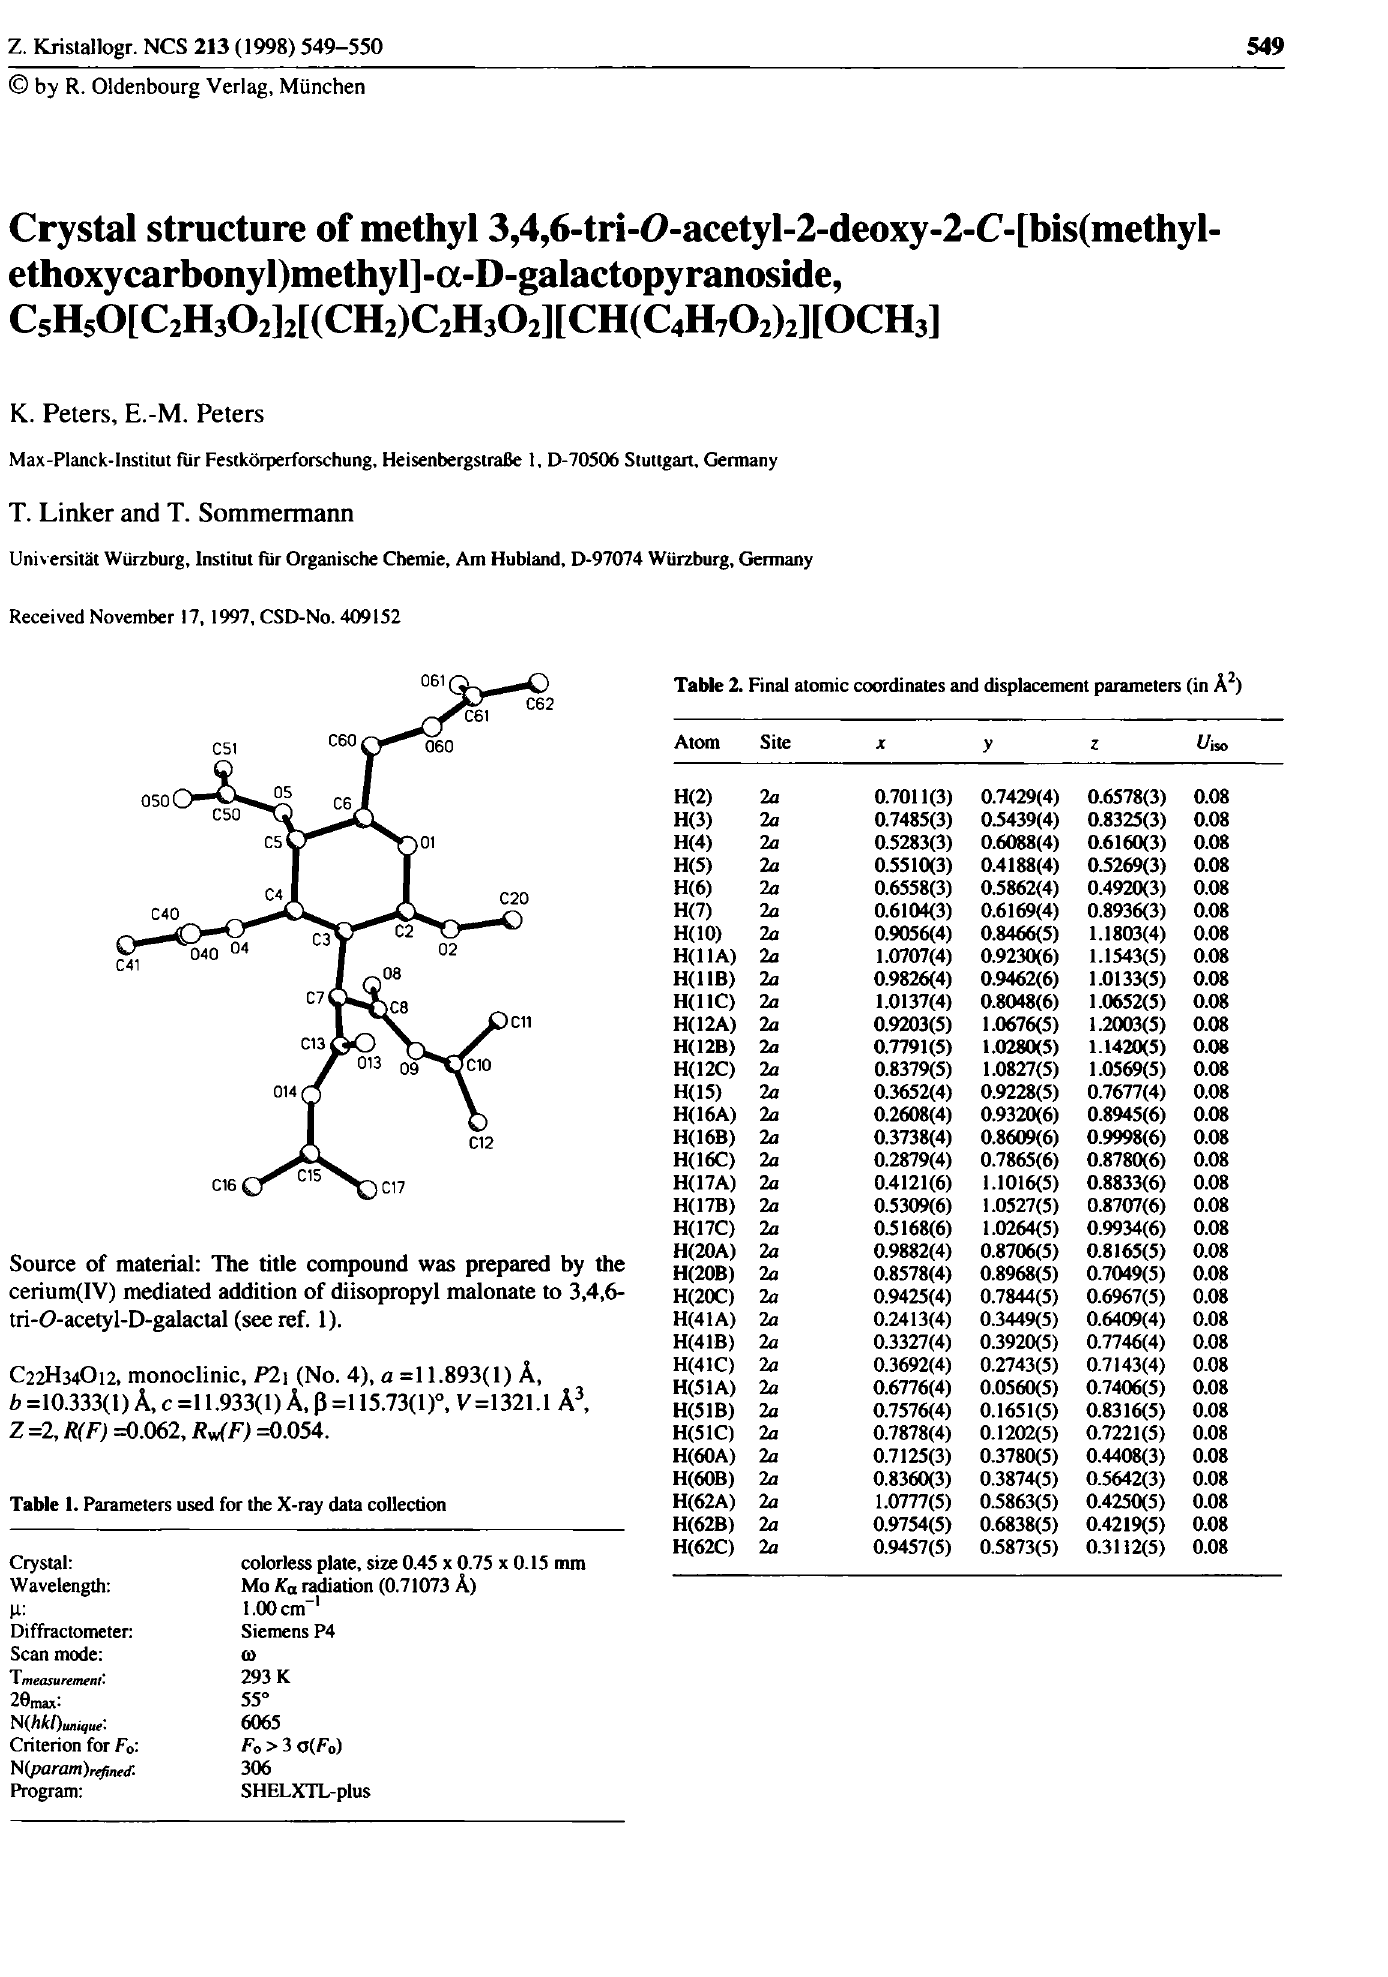
Table 1. Parameters used for the X-ray data collection